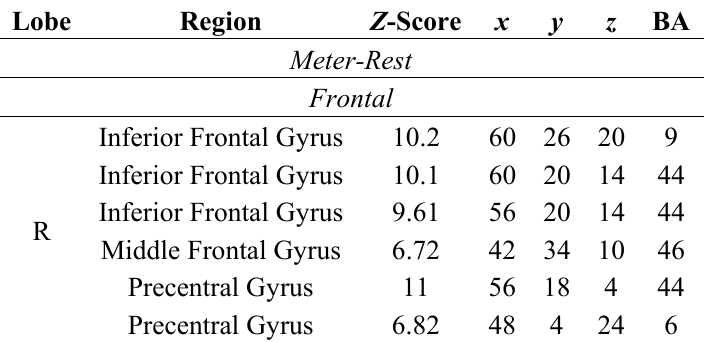
Table 3. Stereotactic MNI coordinates, Z -score values, and anatomical and Brodmann areas for activations during the Meter condition contrasted to